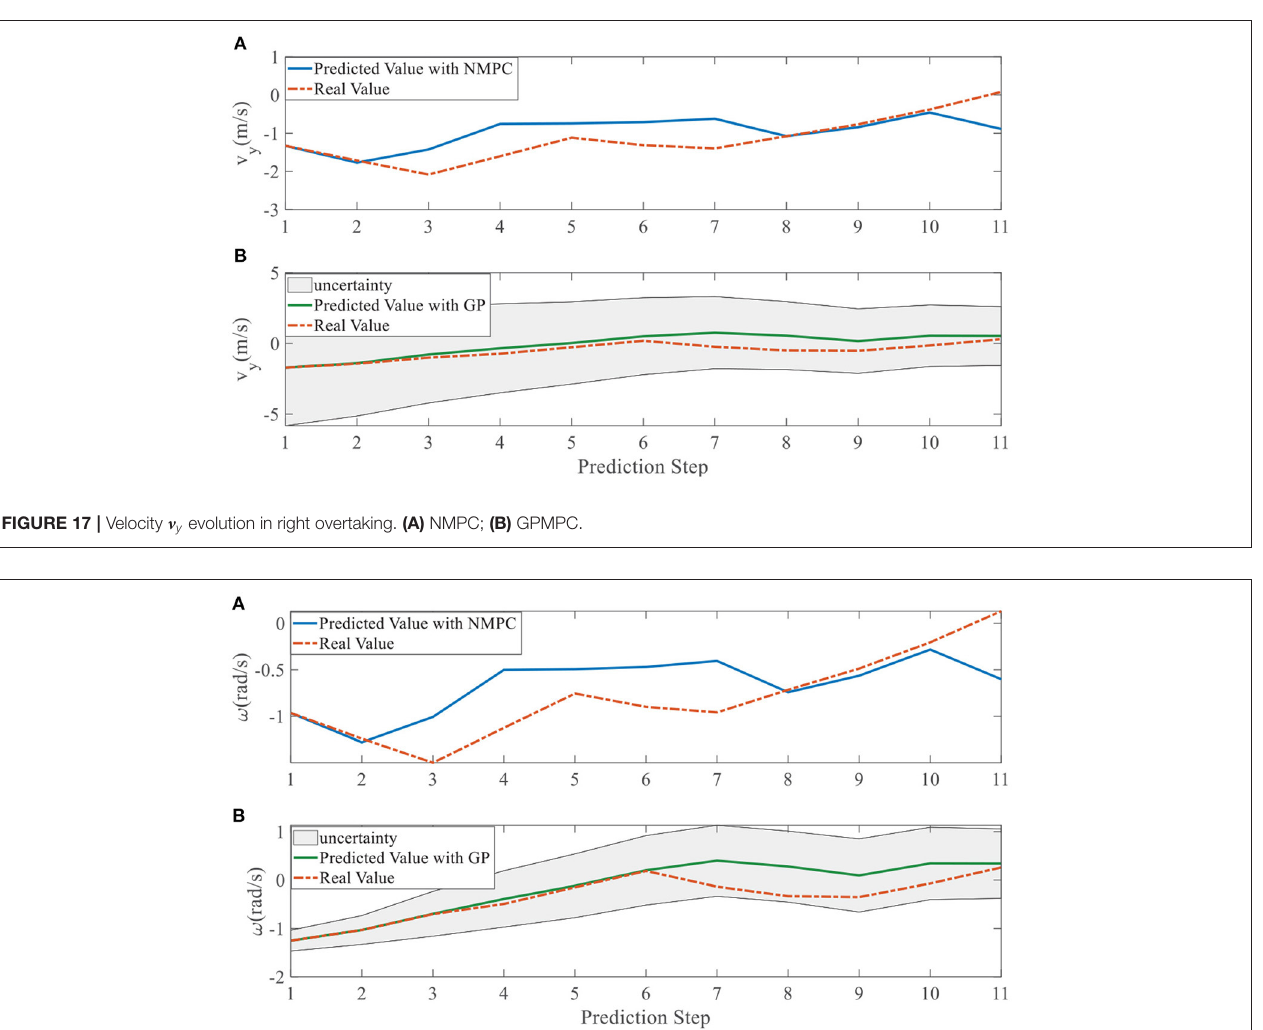
Frontiers in Neurorobotics |